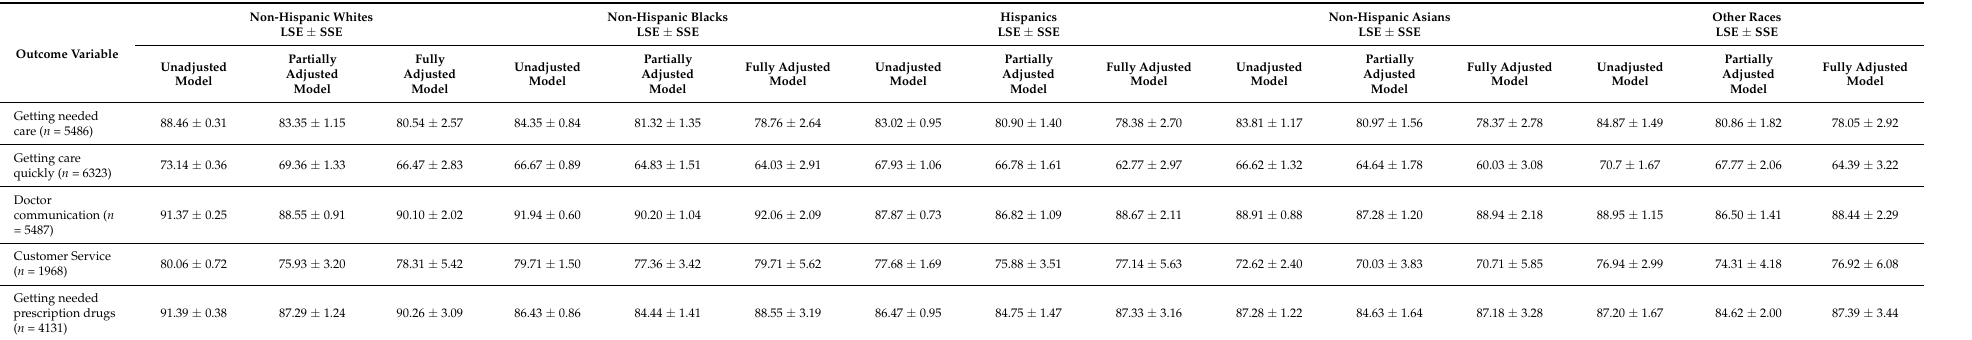
Table 4. Least-square mean estimates of patient experience measures by race/ethnicity for unadjusted, partially adjusted and fully adjusted